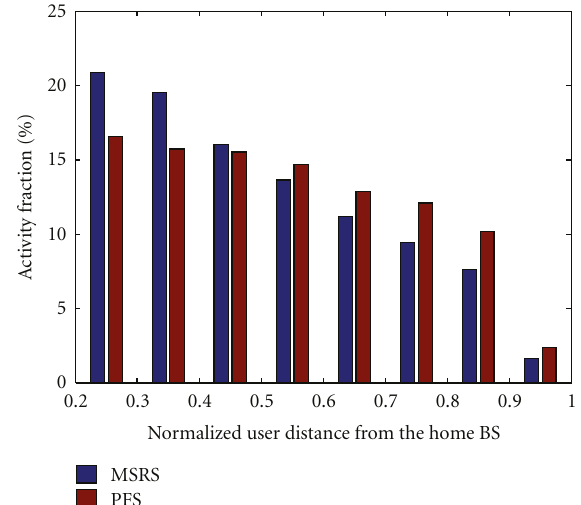
Figure 6: Comparison of activity fraction in percentage for both MSRS and PFS for edge SNR of 10dB.